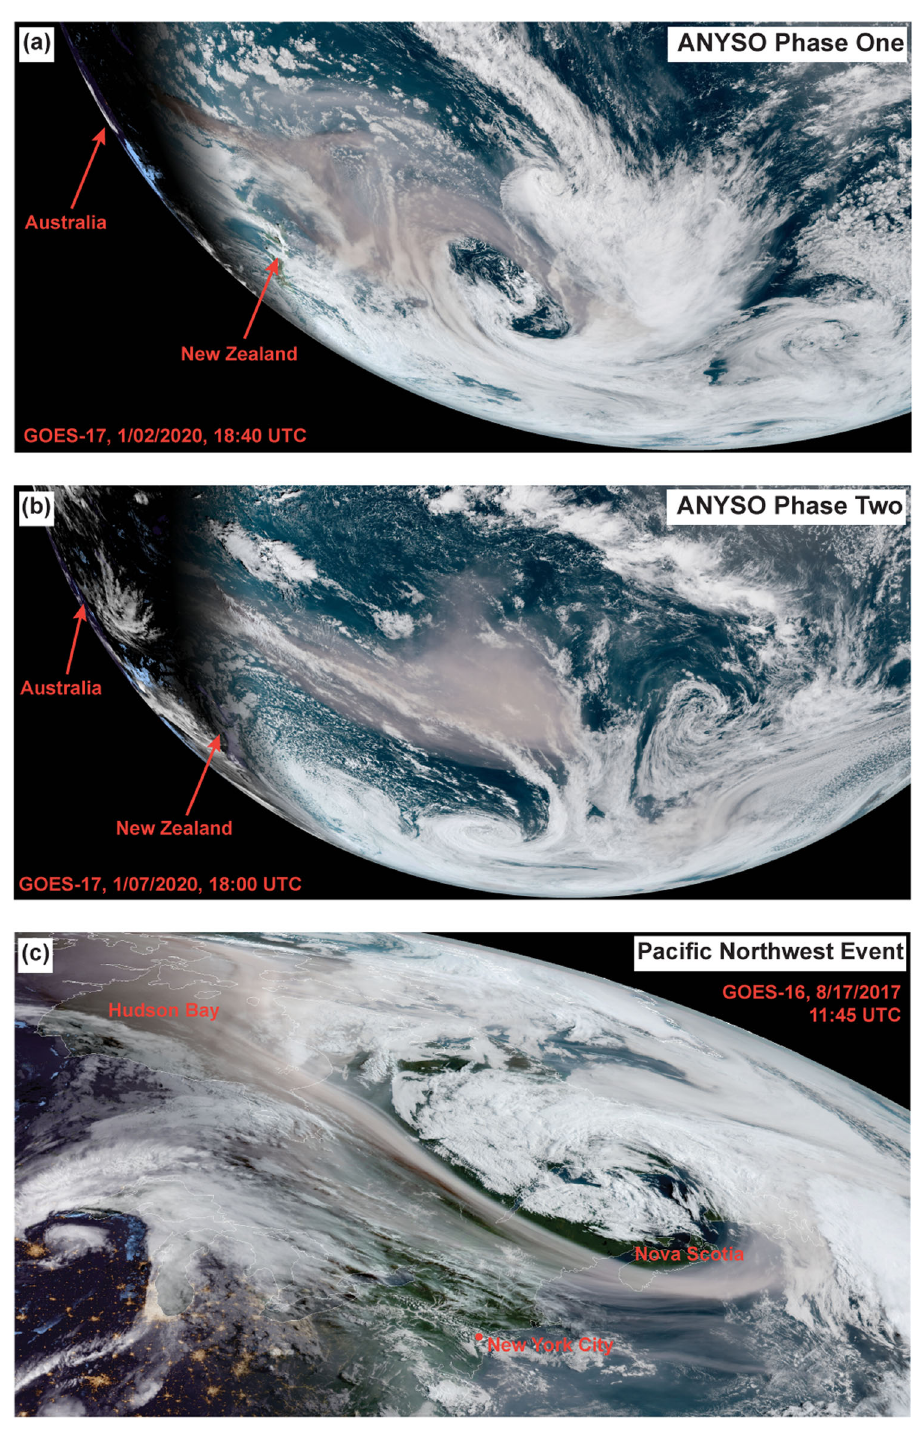
Fig. 2 The three largest pyroCb smoke plumes observed in the stratosphere to date. Each true color image is based on the GeoColor Algorithm (used with permission from the Cooperative Institute for Research in the Atmosphere) near local sunrise within 48 – 72 h of: a ANYSO phase one, b ANYSO phase two, and c the 2017 Paci fi c Northwest Event (PNE). The ANYSO images are from GOES-17. The PNE image (GOES- 16) is adapted from our previous study 2